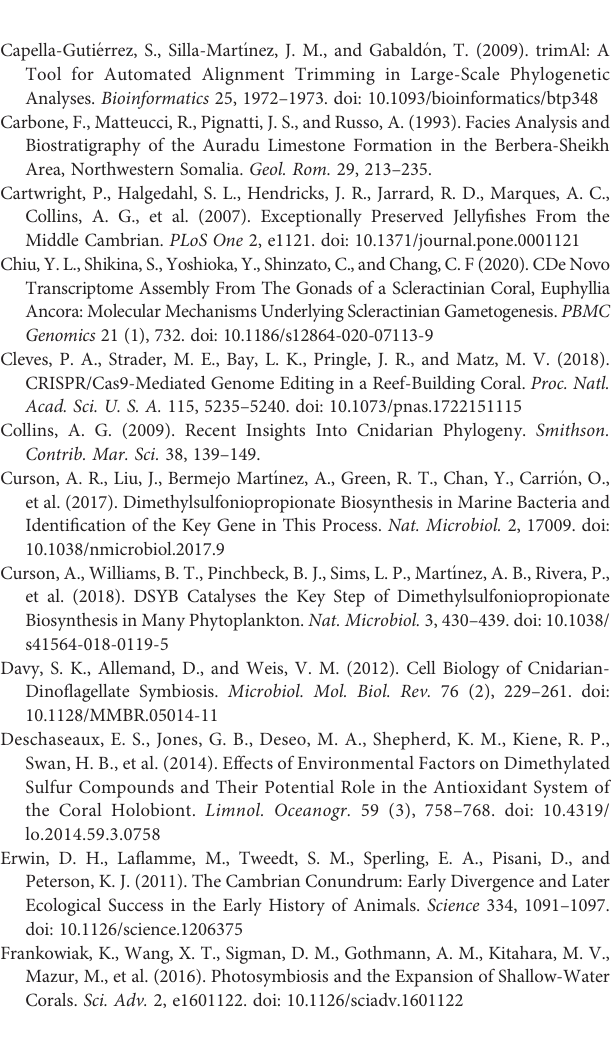
and prokaryotes including, A. digitifera DL-L genes, were aligned using MAFFT v7.310. Then, 337 gap-trimmed aligned amino acid sequences were used for the phylogenetic analysis. Each species name is followed by a different symbol indicating the taxonomy of the species. The bar indicates 0.6 substitutions per site in aligned regions. Supplementary Table 1 | List of the primers for cloning PCR analysis. Supplementary Table 2 | Gene expression levels (counts per million) of Acropora digitifera DL-L genes in different developmental stages (Shinzato et al., 2021a and Yoshiokaetal.,2021)andincreasedseawatertemperature(Shinzatoetal.,2021b). Supplementary Table 3 | DL-L genes in Eukaryotes, excluding cnidarians. Emiliania huxleyi Alma1 (Accession: KR703620.1) and Symbiodinium A1 DMSP lyase (Accession: P0DN22) were used as query sequences in homology searches against the TSA at NCBI using tBlastn (e-value cutoff 1e -5 , query range